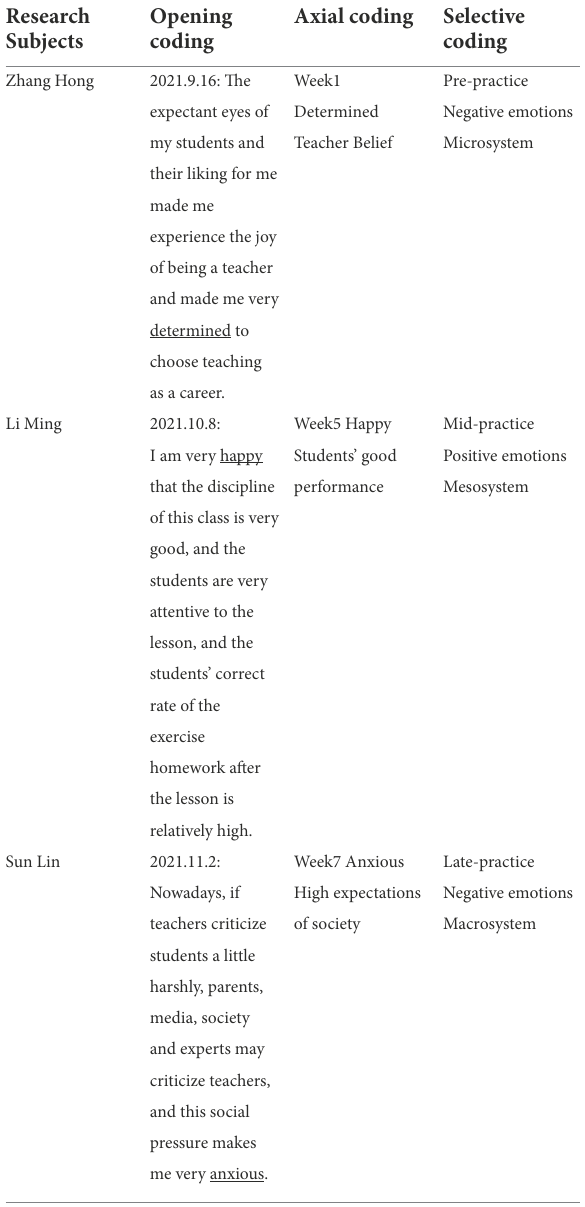
TABLE 2 A sample of data coding